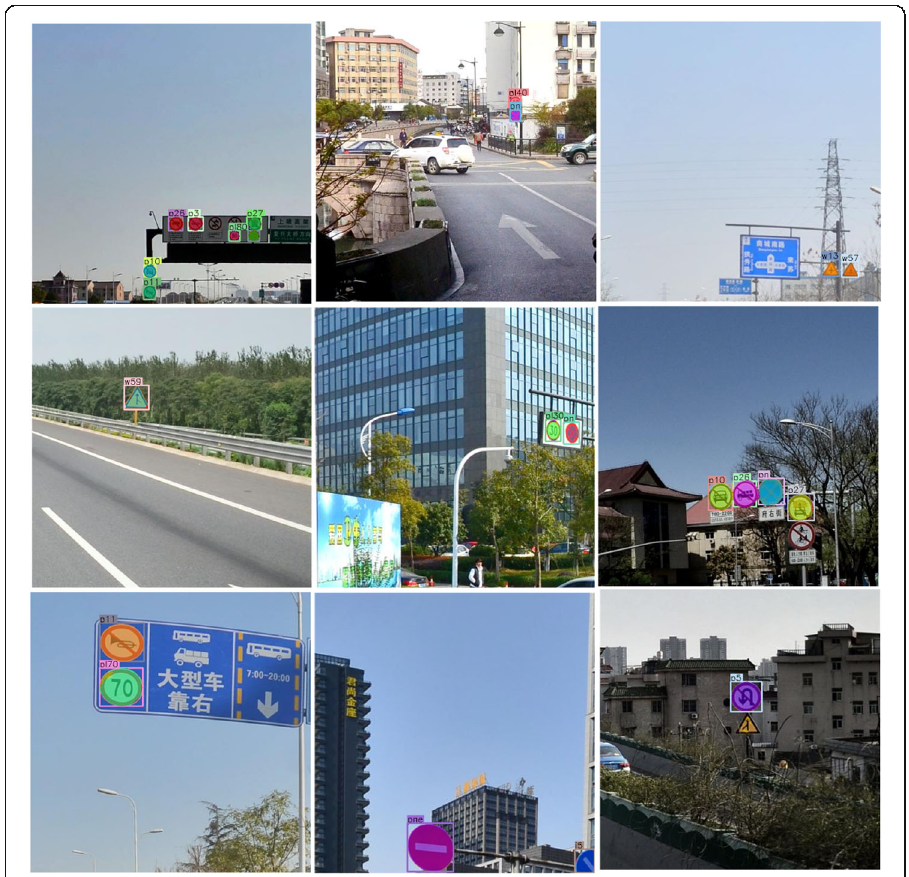
Fig. 5 The data tag is displayed, the left side is the mark for coordinate positioning, and the right side is the label for image